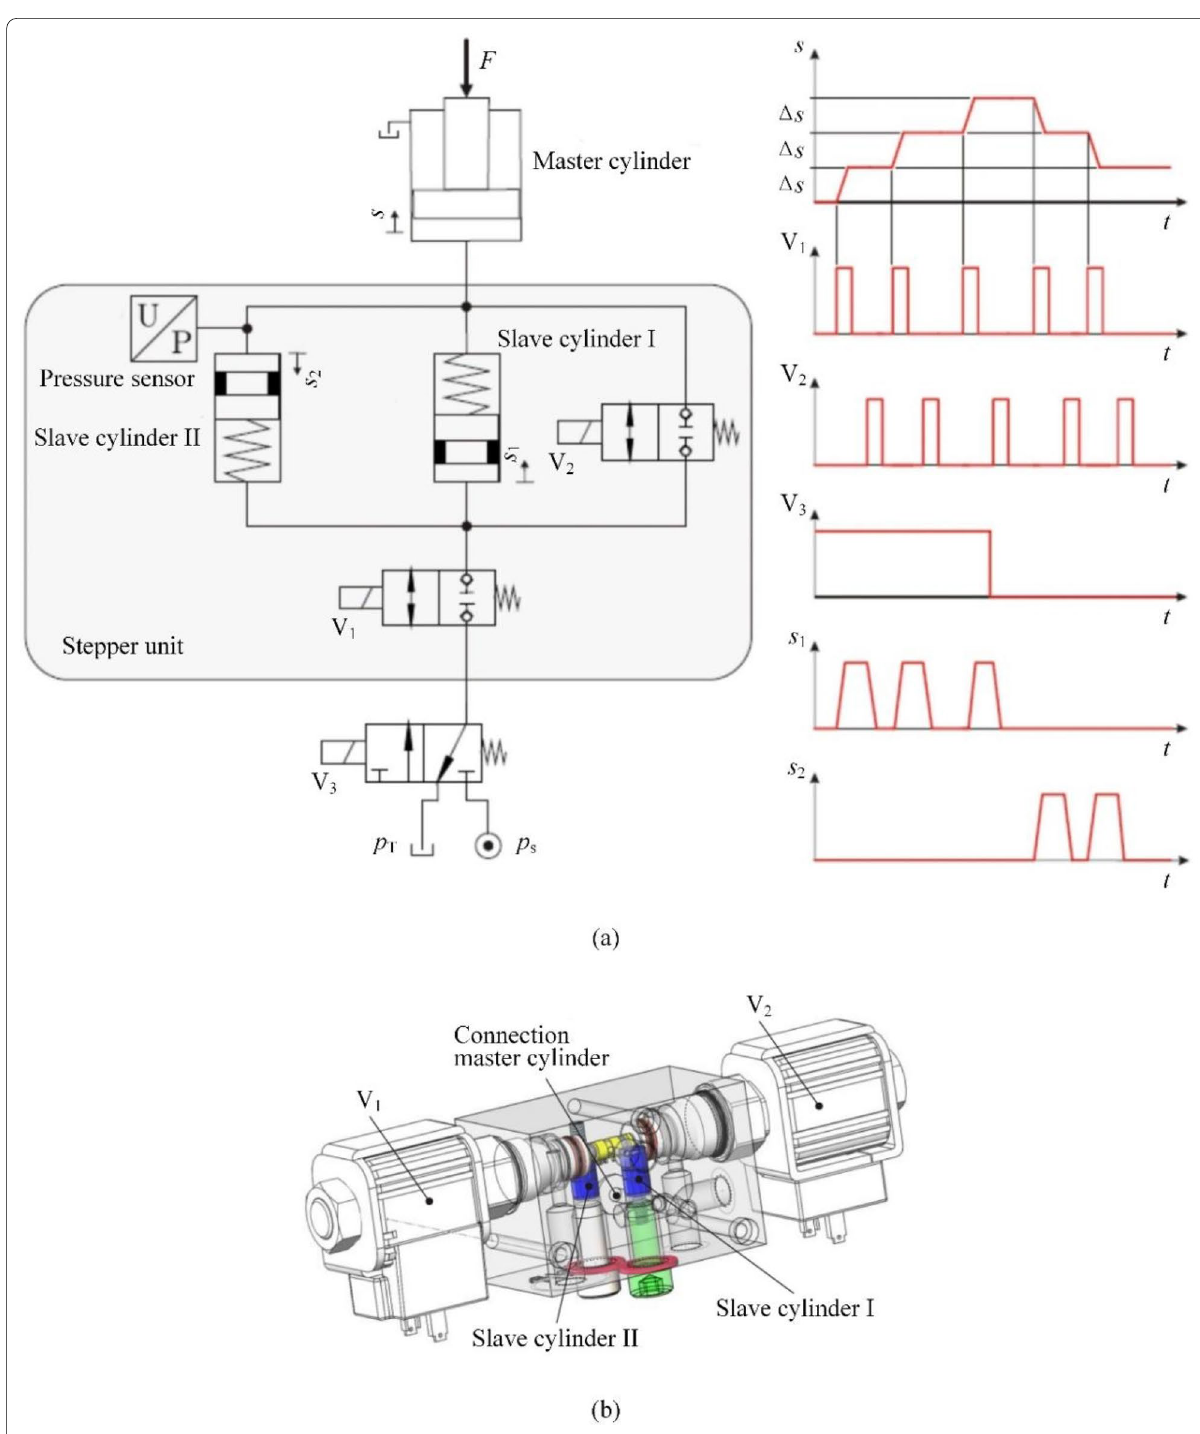
Figure 29 Stepper cylinder designed by Plöckinger et al.: a schematic of the structure and timing diagram, b detail of the stepper